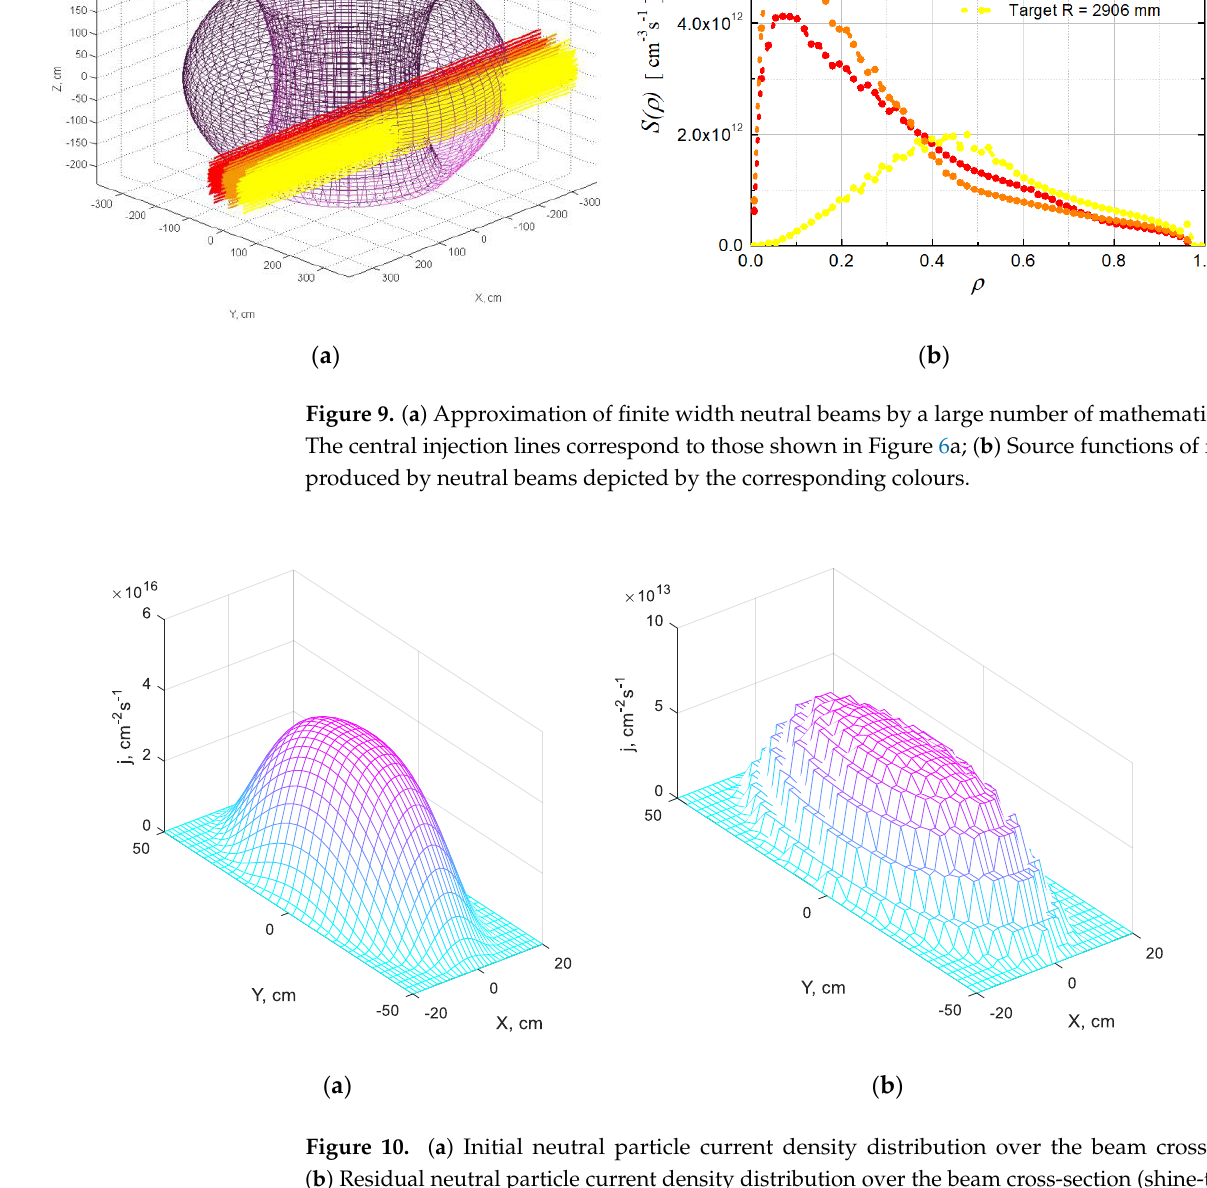
with tangency radius R=2906 mm shown by the yellow colour in Figure 9 (a), the shine- through current density is greater reaching several per cent of the initial current density.